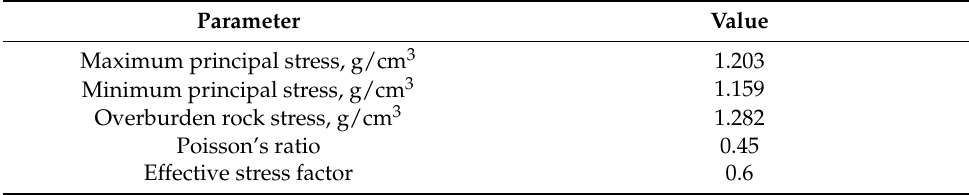
Table 4. Basic parameter values [37,38].